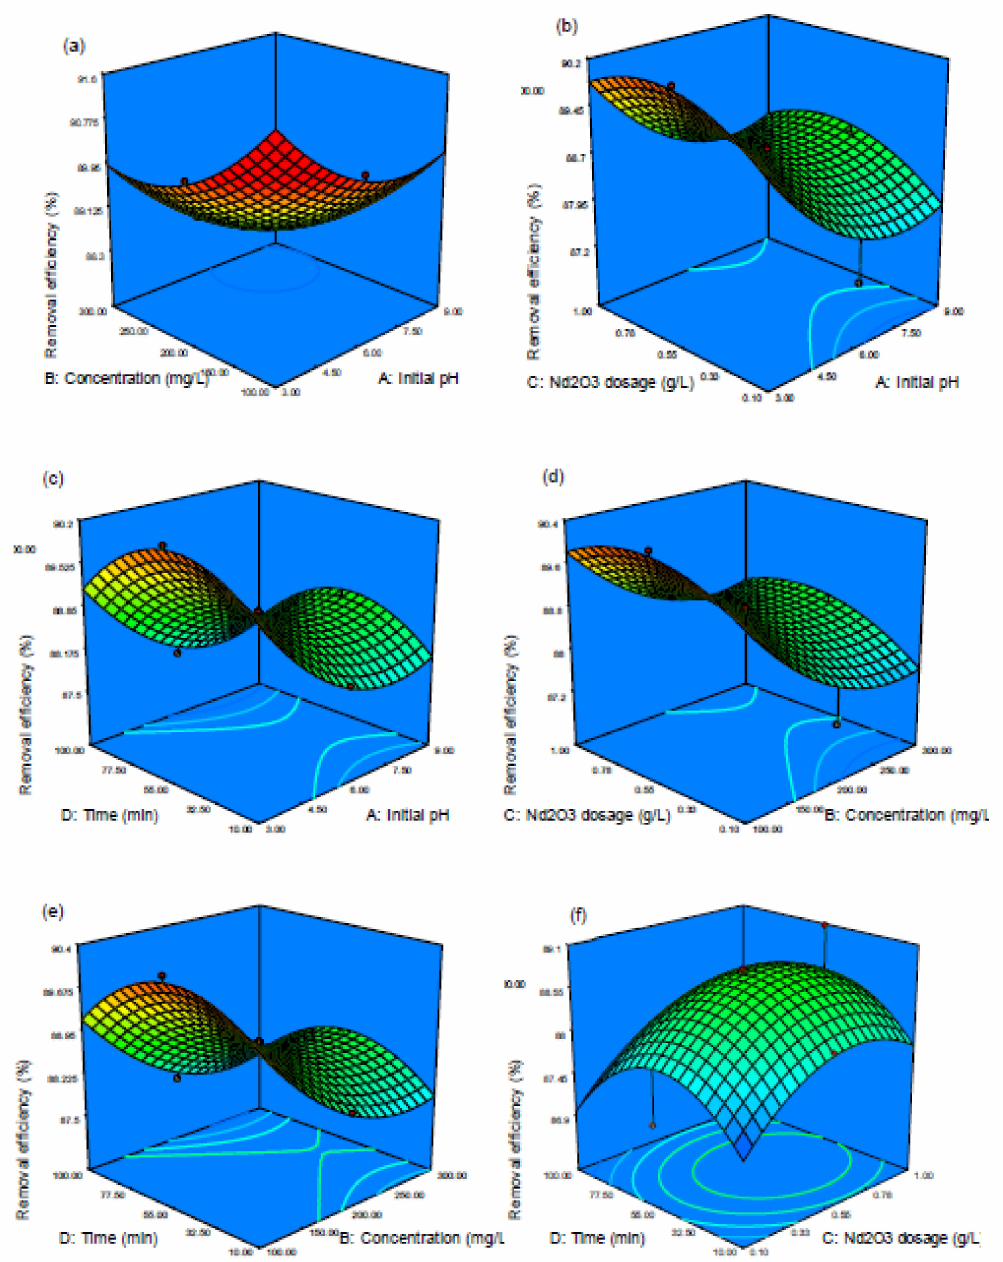
Figure 7. 3D surface plot of the interactive e ff ect of ( a ) AB92 concentration initial and pH, ( b ) Nd 2 O 3 dosage and pH, ( c ) time and pH, ( d ) Nd 2 O 3 nanoparticles dosage and concentration, ( e ) time and concentration, and ( f ) time and Nd 2 O 3 dosage on AB92 adsorption